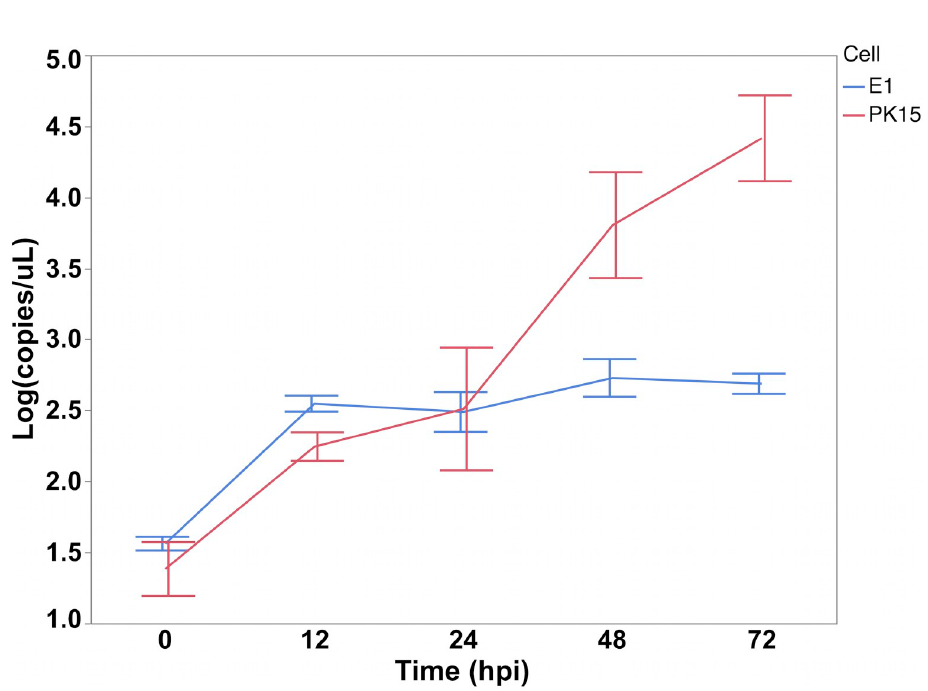
Fig 12. PCV2 copy number in the supernatant obtained from E1 and wildtype PK15 wells following inoculation with the UNL2014001 PCV2b strain. The number of viral copies is expressed as log10 copies/ul.